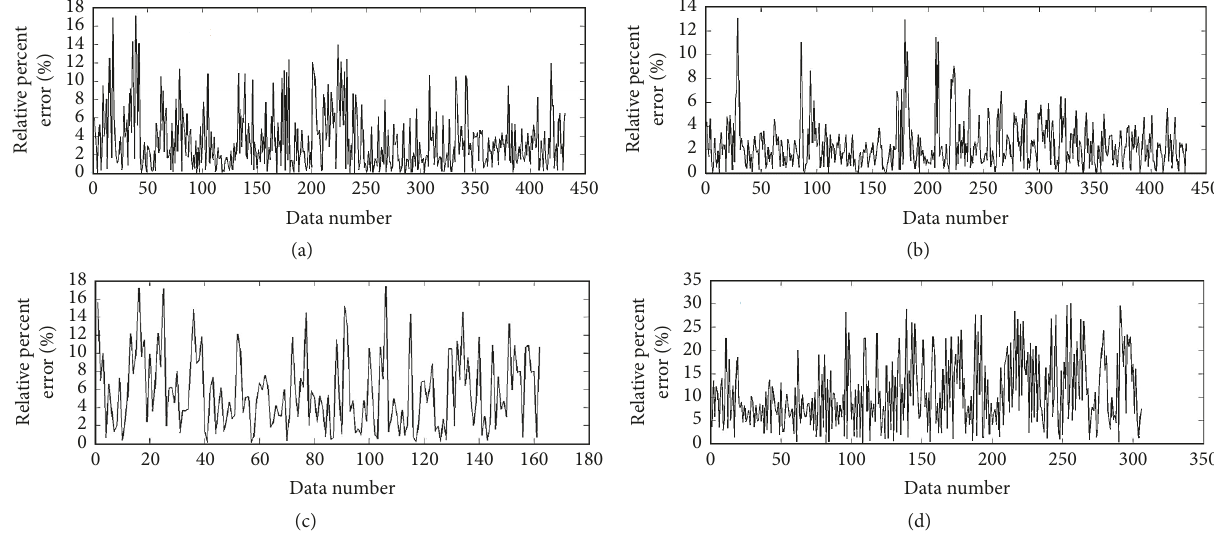
Figure 7: Relative percent errors of the equations ( ∗ )–( ∗ ∗ ∗∗ ) in Table 3 ((a)–(d), resp.) for the whole data